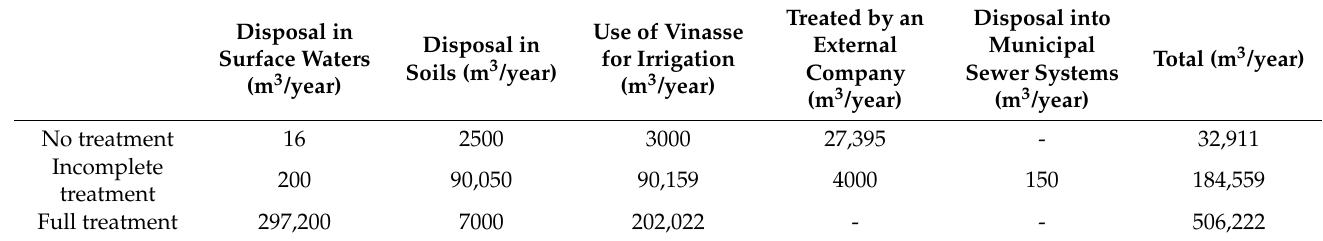
Table 6. Disposal methods according to the information collected in the field study.